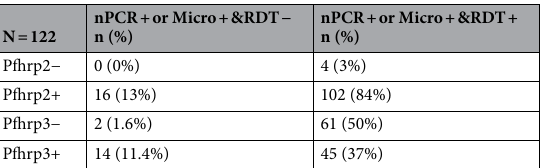
Table 2. Discordance between microscopy, nPCR, RDT and pfhrp2/3 PCR results.